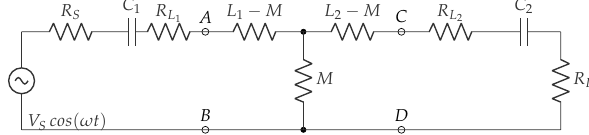
Figure 8. MRC system with one receiver: equivalent